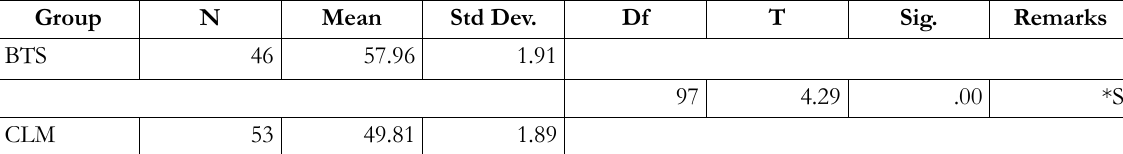
Table 5. T-test Analysis of BBT method on Student’s